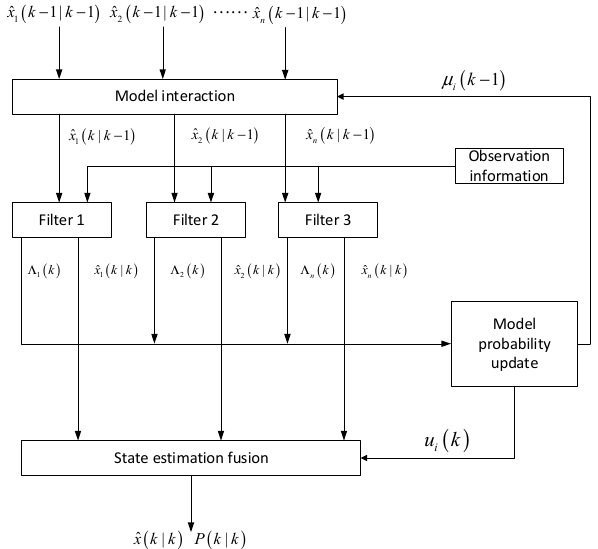
Figure 4. Computational steps of the interactive multi-model algorithm. Each filter is an independent model. The observation information is introduced, the target motion state is obtained by filtering, and finally the state fusion is carried out by weighting.